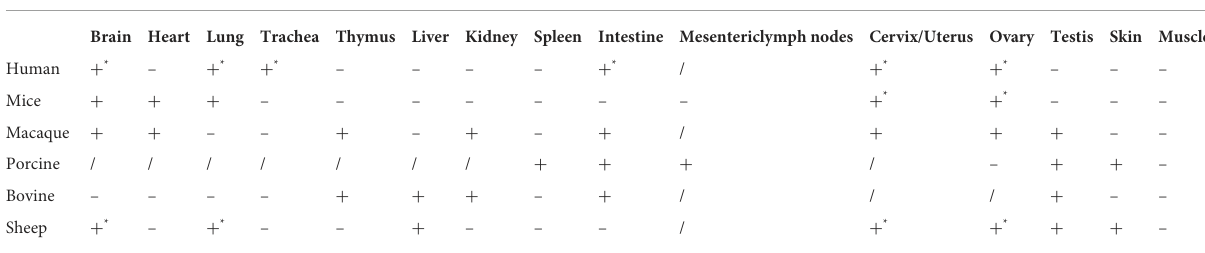
TABLE 3 IFN- ε tissue distribution in different species. Species